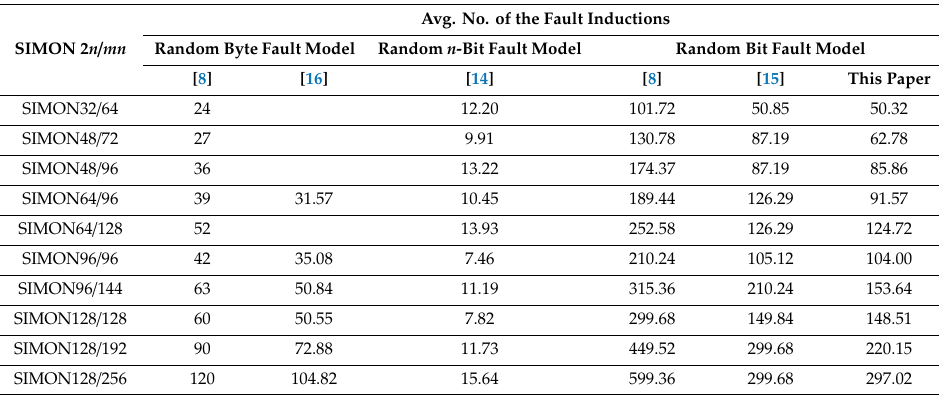
Table 9. Comparison of the experimental results of the fault inductions.